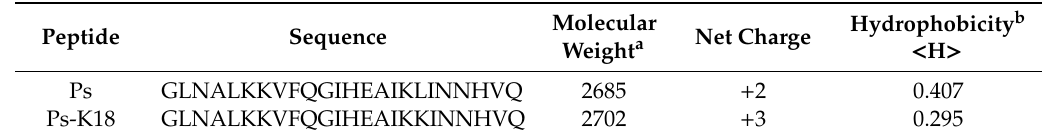
Table 1. Amino acid sequences and peptide properties.